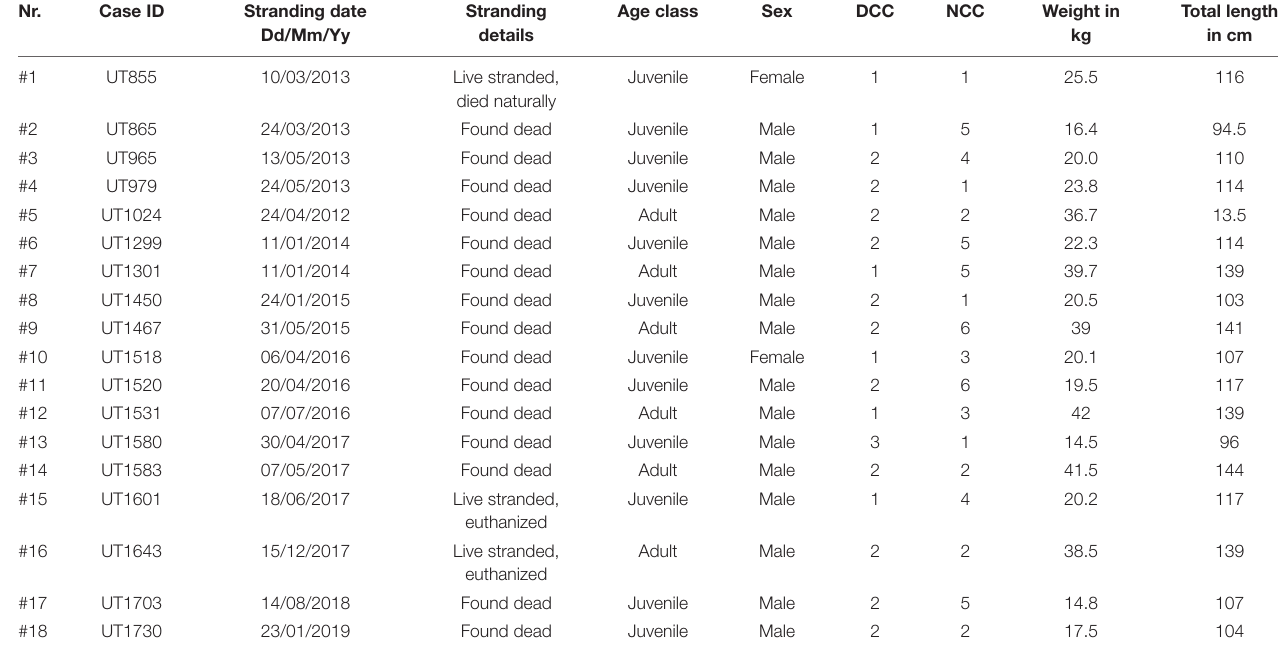
TABLE 1 | Biological information of harbor porpoises with fungal